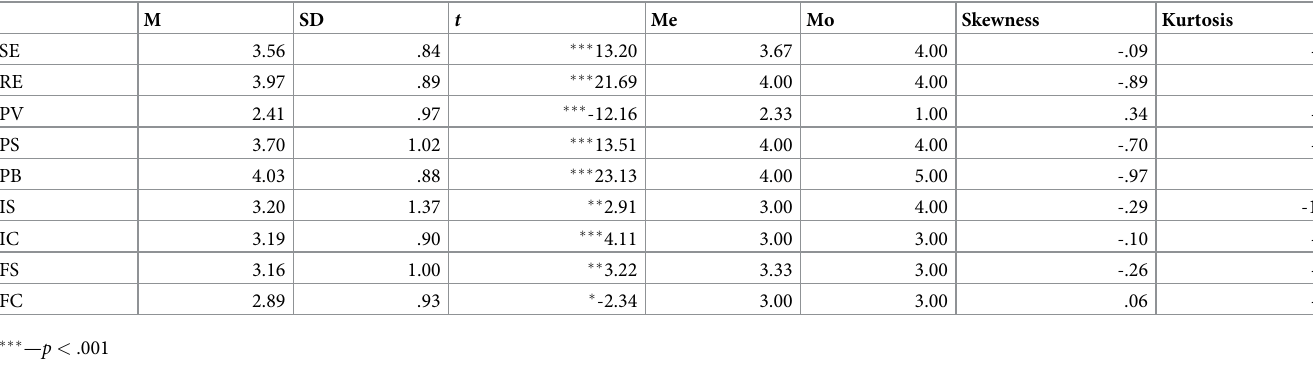
Table 4. Descriptive statistics